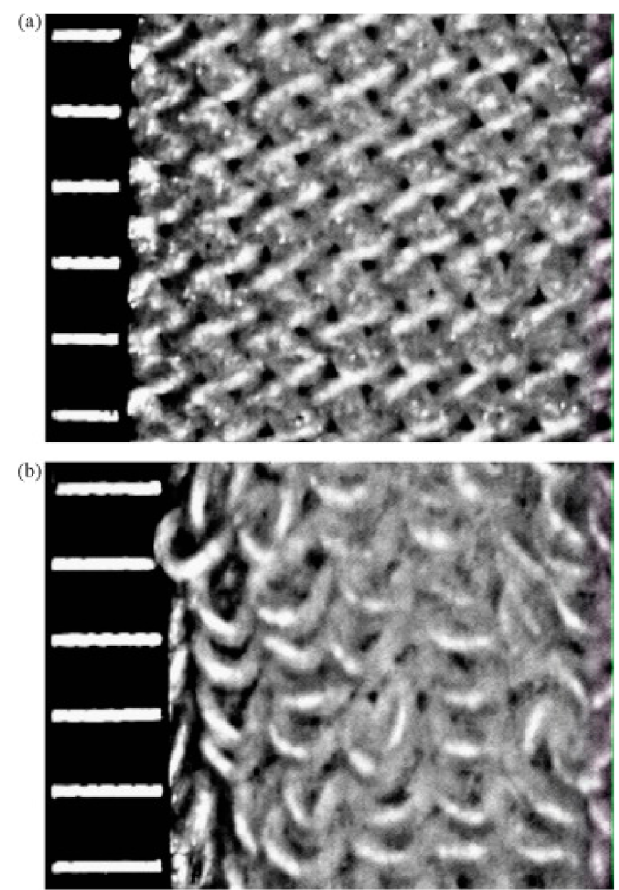
Figure 8. Sock structure: ( a ) basic terry which has a single cotton yarn structure and ( b ) jersey terry which has a second yarn to form stitches on the back yarn [68]. Reproduced with permission from Baussan, E.; Bueno, M.A.; Rossi, R.M.; Derler, S., Experiments and modelling of skin-knitted fabric friction; published by Elsevier,